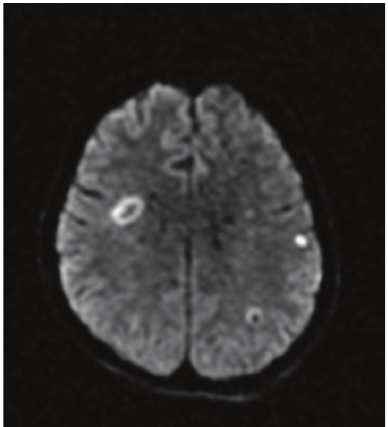
Figure 1: Diffusion-weighted image at the axial plane depicts bilateral ischemic foci at parietal lobes.